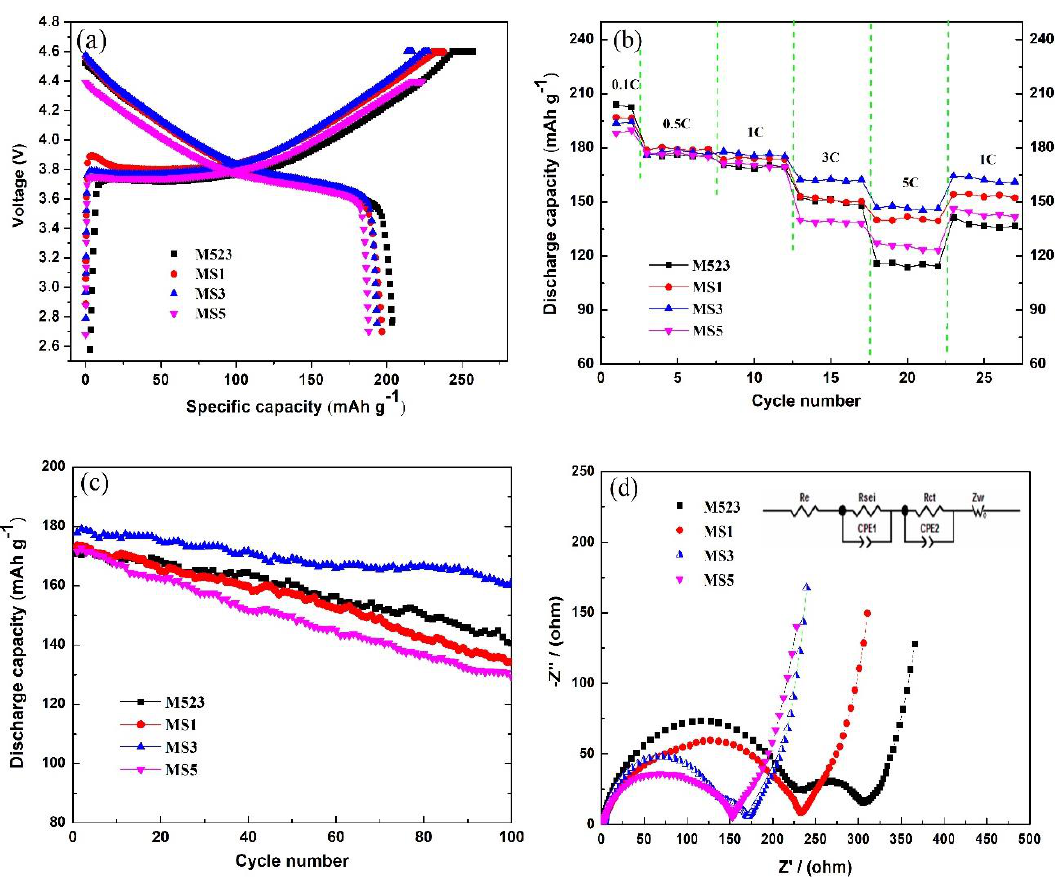
Figure 5. Electrochemical performance of Sn-modified LiNi 0.5 Co 0.2 Mn 0.3 O 2 samples: ( a ) Initial charge–discharge curves at 0.1C, ( b ) rate performance from 0.1 to 5C, ( c ) cyclic ability at 1C, and ( d ) electrochemical impedance spectroscopy (EIS) plots of Sn-modified LiNi 0.5 Co 0.2 Mn 0.3 O 2 samples after the 100th cycle.